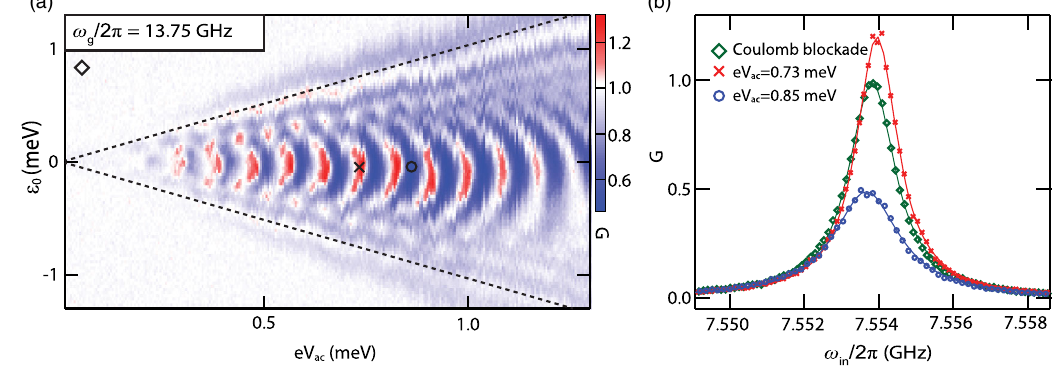
FIG. 2. (a) Floquet gain medium interference pattern. The cavity power gain G plotted as a function of offset detuning ϵ 0 and ac drive amplitude eV . A pattern of alternating gain ( G > 1 , red regions) and loss ( G < 1 , blue regions) is observed. (b) G plotted as a function ac = 2 π with the DQD in Coulomb blockade (green diamond), with the DQD drive configured for loss ( eV of ω in blue circle), and with the DQD drive configured for gain ( eV